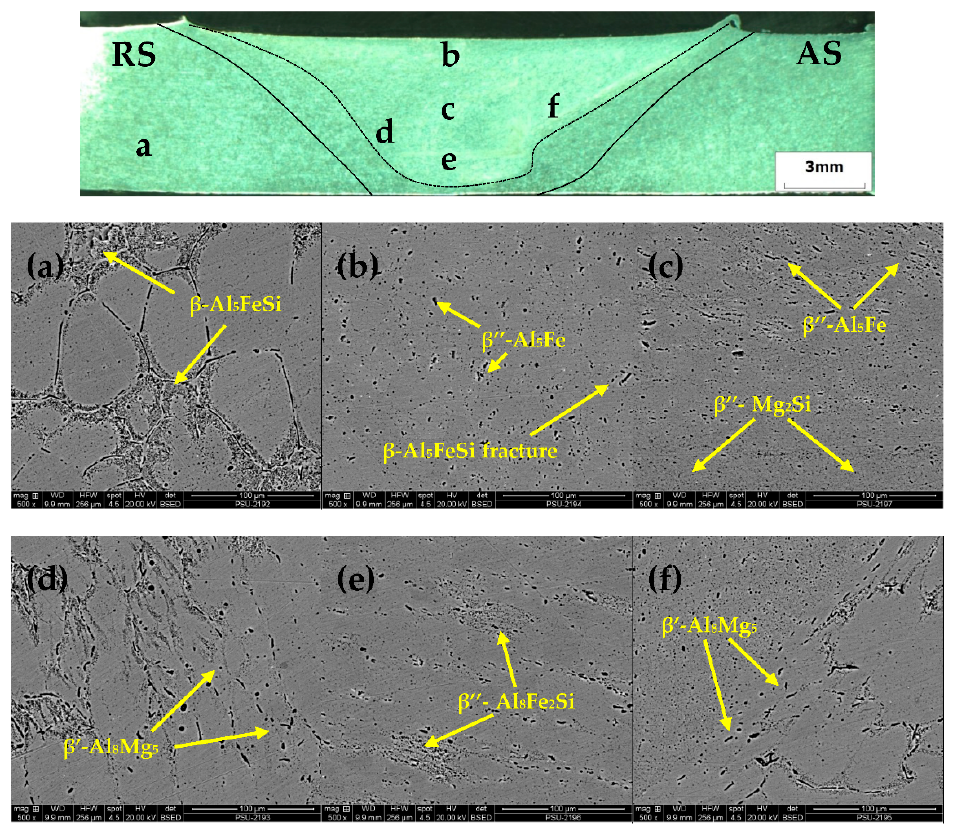
Figure 10. The evaluated of the microstructure in the welded joint by SEM from cylindrical tool, rotation speed at 1320 rpm, and welding speed at 60 mm/min. ( a – f ) six patterns of microstructural changes were observed.